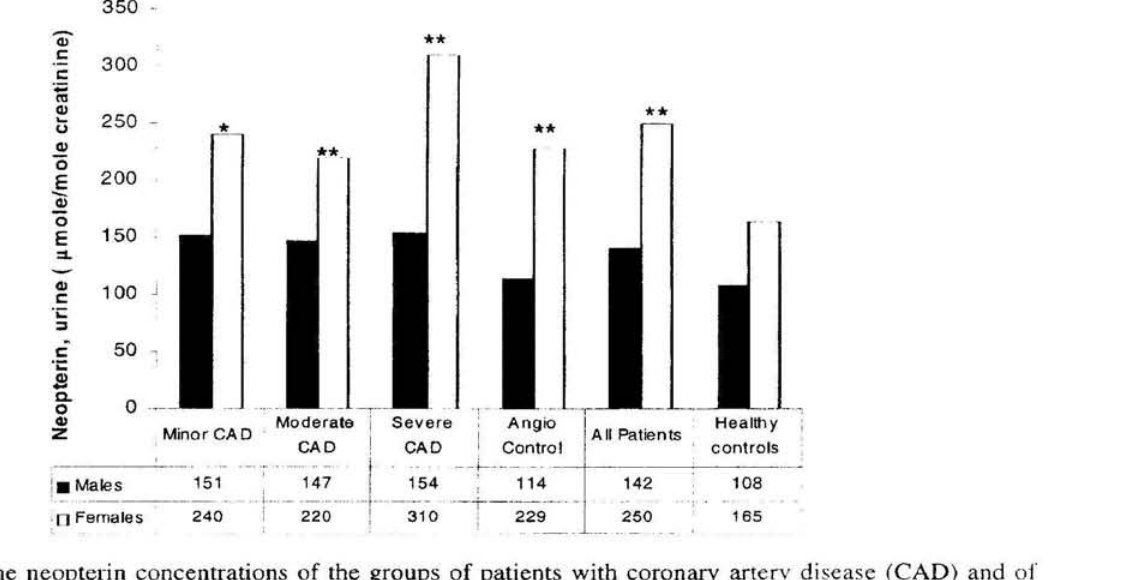
Figure 2. Urine neopterin concentrations of the groups of patients with coronary artery disease (CAD) and of healthy controls stratified for gender. Data are presented as means. *p <0.05, males vs females within patients with minor CAD **p <0.01, males vs females within each group Fteridines/Vol. 15/No.